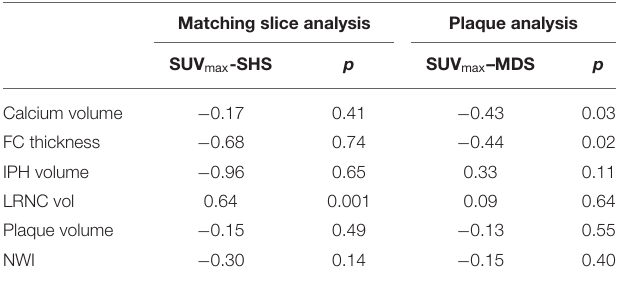
TABLE 3 | Correlation between plaque FDG uptake and plaque MRI features (Spearman’s correlation coefficient). Matching slice analysis Plaque analysis